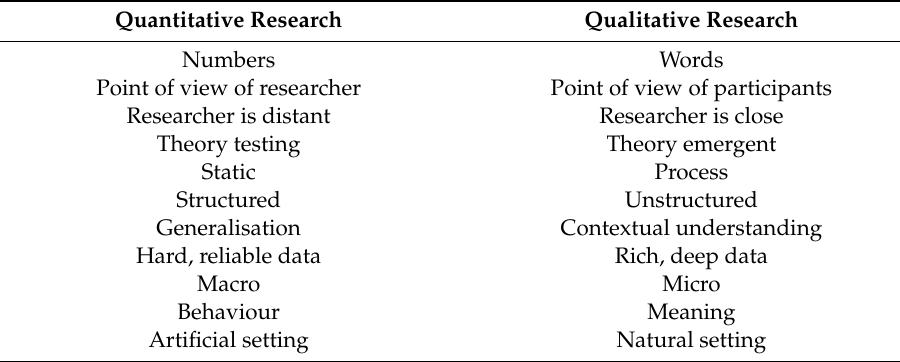
Table 3. Contrasting quantitative and qualitative